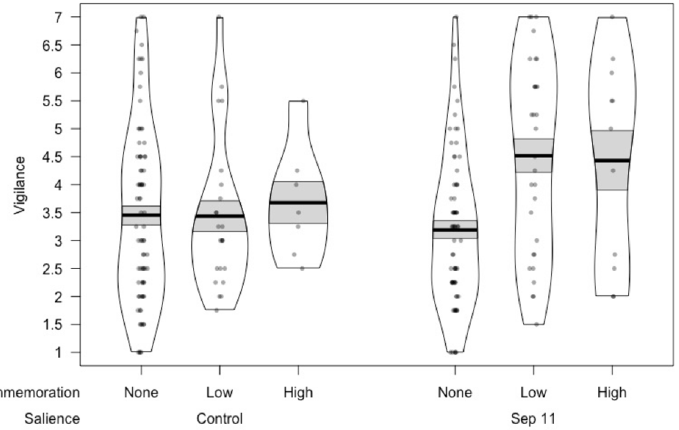
Figure 2. The interaction between salience of commemoration and level of commemoration engagement, Study 2. Horizontal bars represent unadjusted means. Shaded bands represent standard